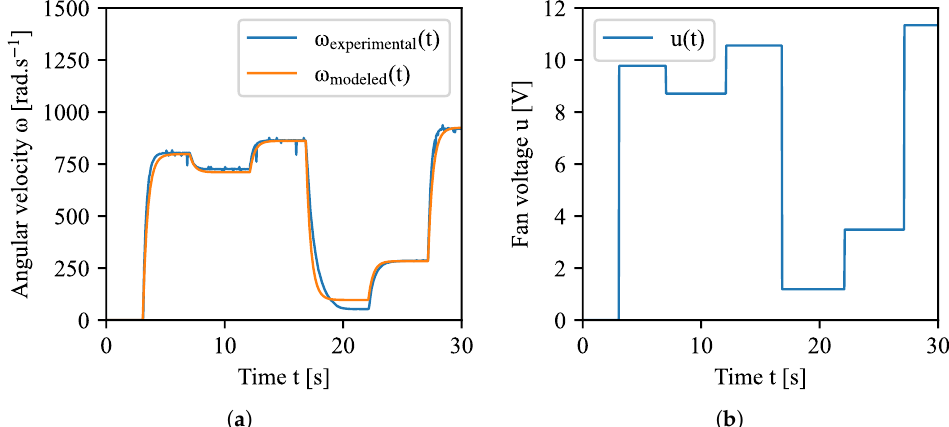
Figure 8. Fan’s mathematical model validation. ( a ) Real plant compared to modeled fan angular velocity ω ( t ) ; ( b ) fan’s input voltage u ( t )